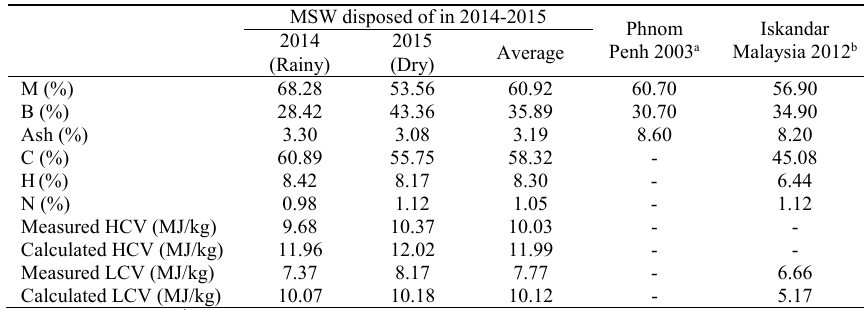
Table 5: Chemical characteristics of municipal solid waste